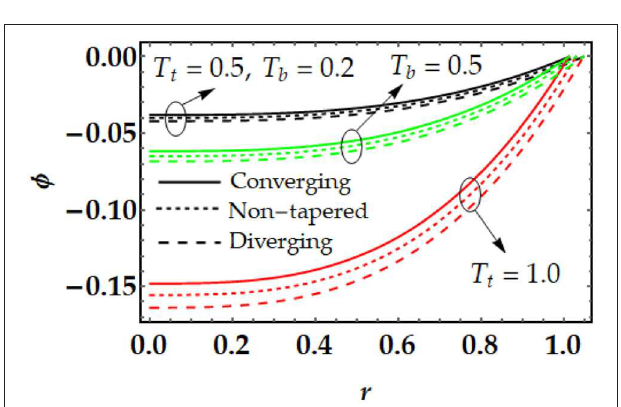
FIGURE 4 | Concentration curves for multiple values of T b , T t